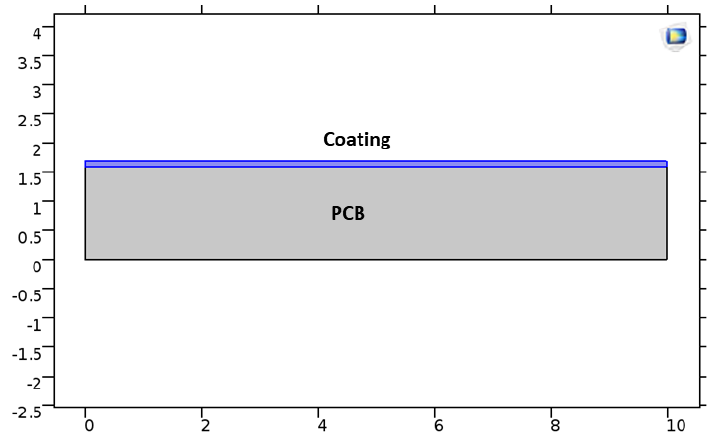
Figure 8. Geometry of 2D FEA modeling of a bi-layer sheet; x, y units are in mm. The conformal coating thickness is taken equal to 0.1 mm; therefore, a distance equal to 0.0001 mm from the edge corresponds to an x/h a value of 0.001 in Figure 7. A free